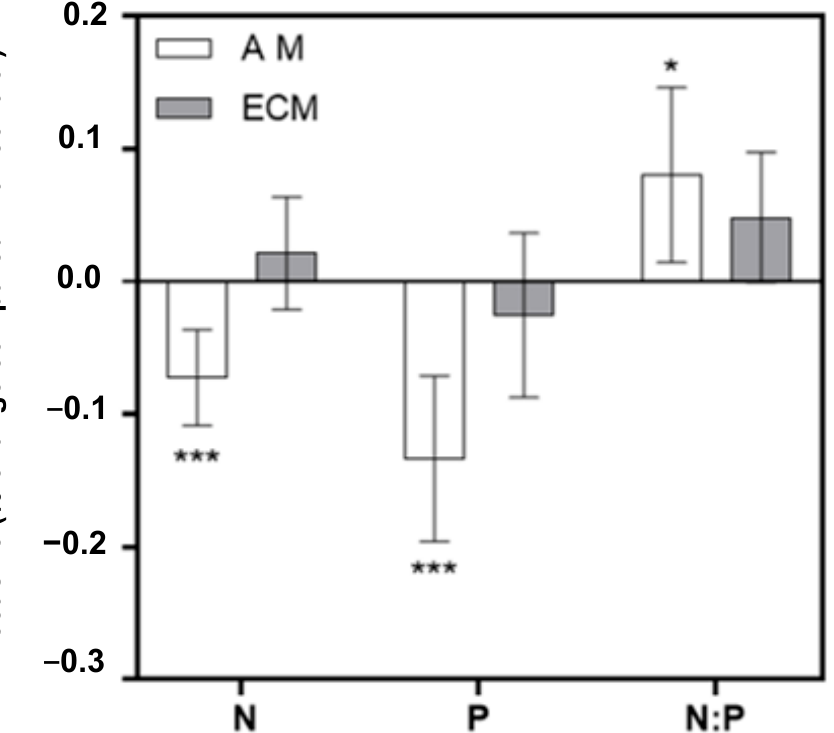
Figure 1. The error bar represents a 95% bootstrap confidence interval (CIs). If log e R 95% CI did not overlap with zero, the effect of drought stress was considered significant. Here "*" means significant difference, and "***" means very significant difference.